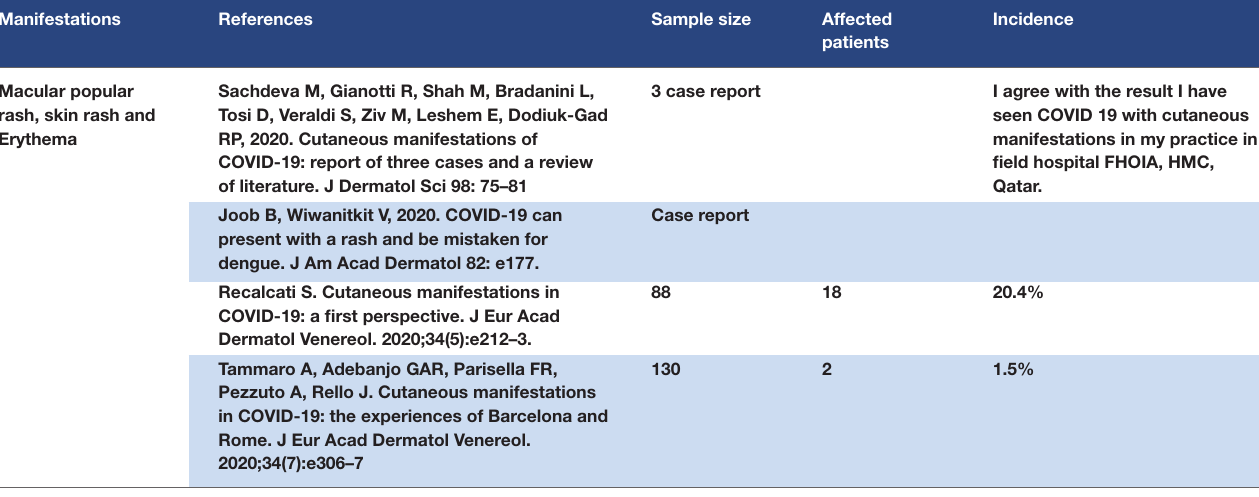
TABLE 7 | Skin manifestations of COVID 19.